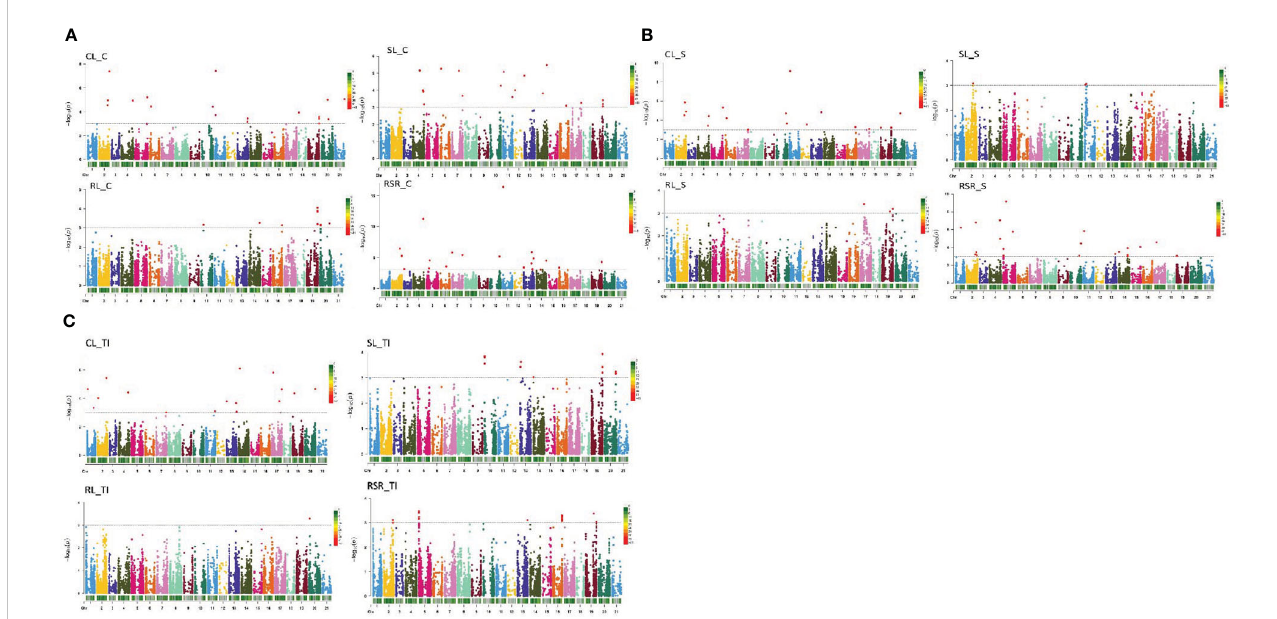
FIGURE 4 (A) Manhattan plots showing signi fi cant QTN (quantitative trait nucleotides) in 261 winter wheat genotypes used for seedling growth parameters (CL, SL, RL and RSR) under control conditions. Signi fi cant QTNs are indicated with red dots (P<0.001; -log10>3). (B) Manhattan plots showing signi fi cant QTN (quantitative trait nucleotides) in 261 winter wheat genotypes used for seedling growth parameters (CL, SL, RL and RSR) under stress conditions. Signi fi cant QTNs are indicated with red dots (P<0.001; -log10>3). (C) Manhattan plots showing signi fi cant QTN (quantitative trait nucleotides) in 261 winter wheat genotypes used for seedling growth tolerance index (CL, SL, RL and RSR). Signi fi cant QTNs are indicated with red dots (P<0.001;